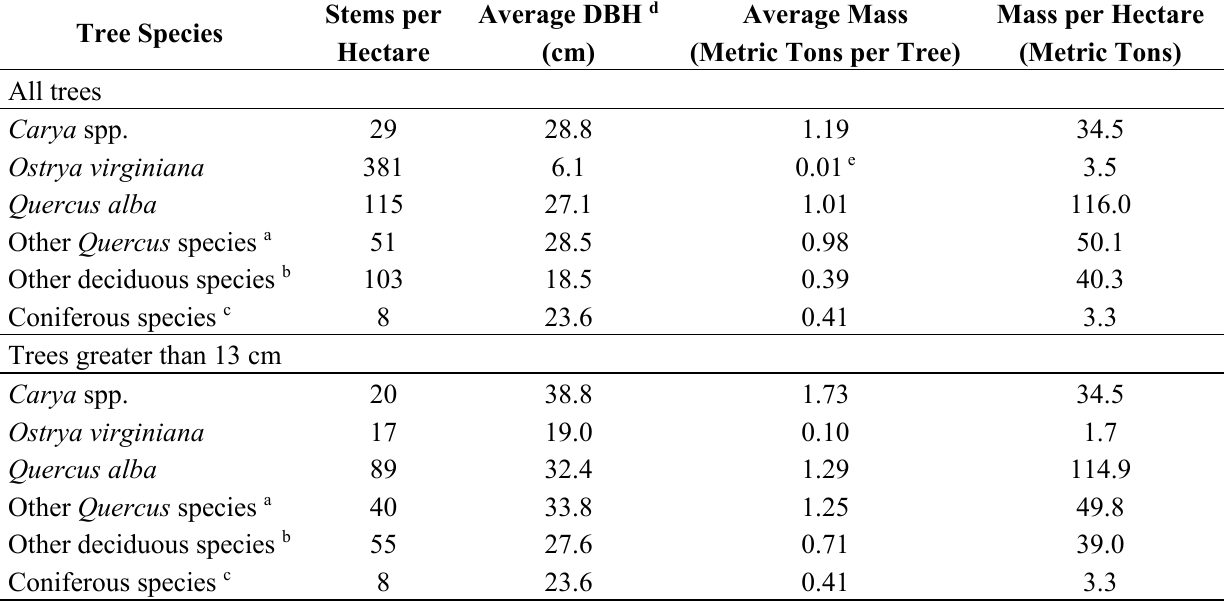
Table 1. Characteristics of the case study uneven-aged oak-hickory stand in Georgia (eastern United States).